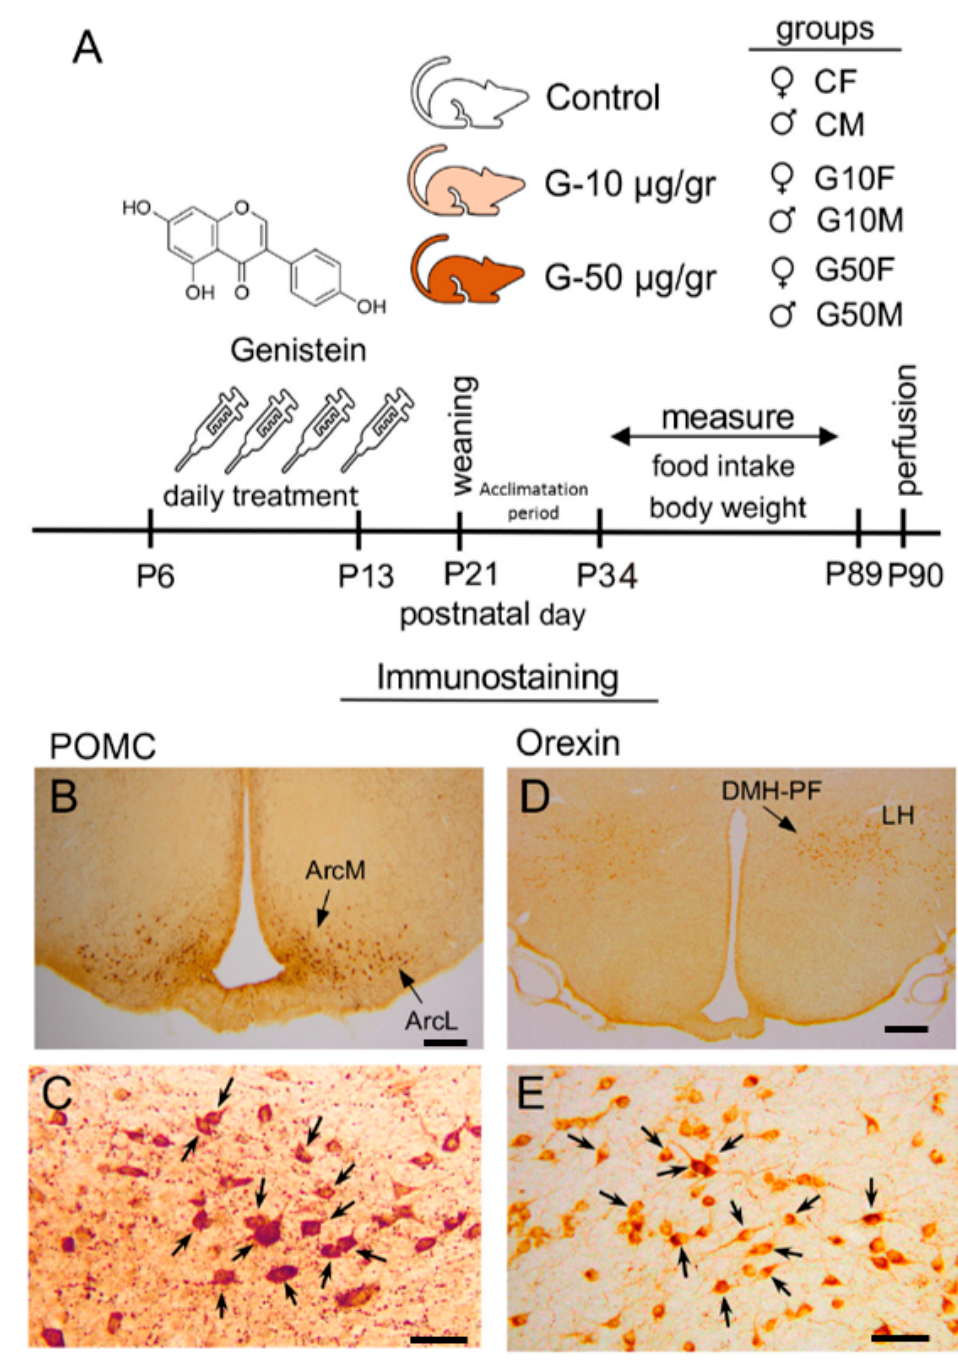
Figure 2. ( A ) Schematic representation of the procedure used from treatment to immunostaining. From P6 to P13, daily injections of synthetic genistein (10 or 50 µg/g) or vehicle according to experimental group were administered. From weaning on P21 to P34, an acclimatization period was implemented. Food intake and body weight were measured weekly from P34 until P89. Animals were sacrificed on P90. ( B , C ) Photomicrographs showing the distribution of immunostaining of POMC-ir positive cells in Arc nucleus. ( D , E ) Orexin-ir positive cells in the PF and LH. Arrows show orexin-ir and POMC-ir positive cells counted. ArcM: arcuate medial subdivision, ArcL: arcuate lateral subdivision; LH: lateral nucleus of the hypothalamus; DMH-PF: dorsomedial-perifornical nucleus B Bar = 200 µm; C Bar = 50 µm ; D Bar = 300 µm; E Bar = 75 µm [44]. No differences between the hemispheres were found in the PF-DMH continuum (F1,54 = 0.926; p = 0.402) or the LH (F1,54 = 1.196; p = 0.310). Moreover, no main effect of